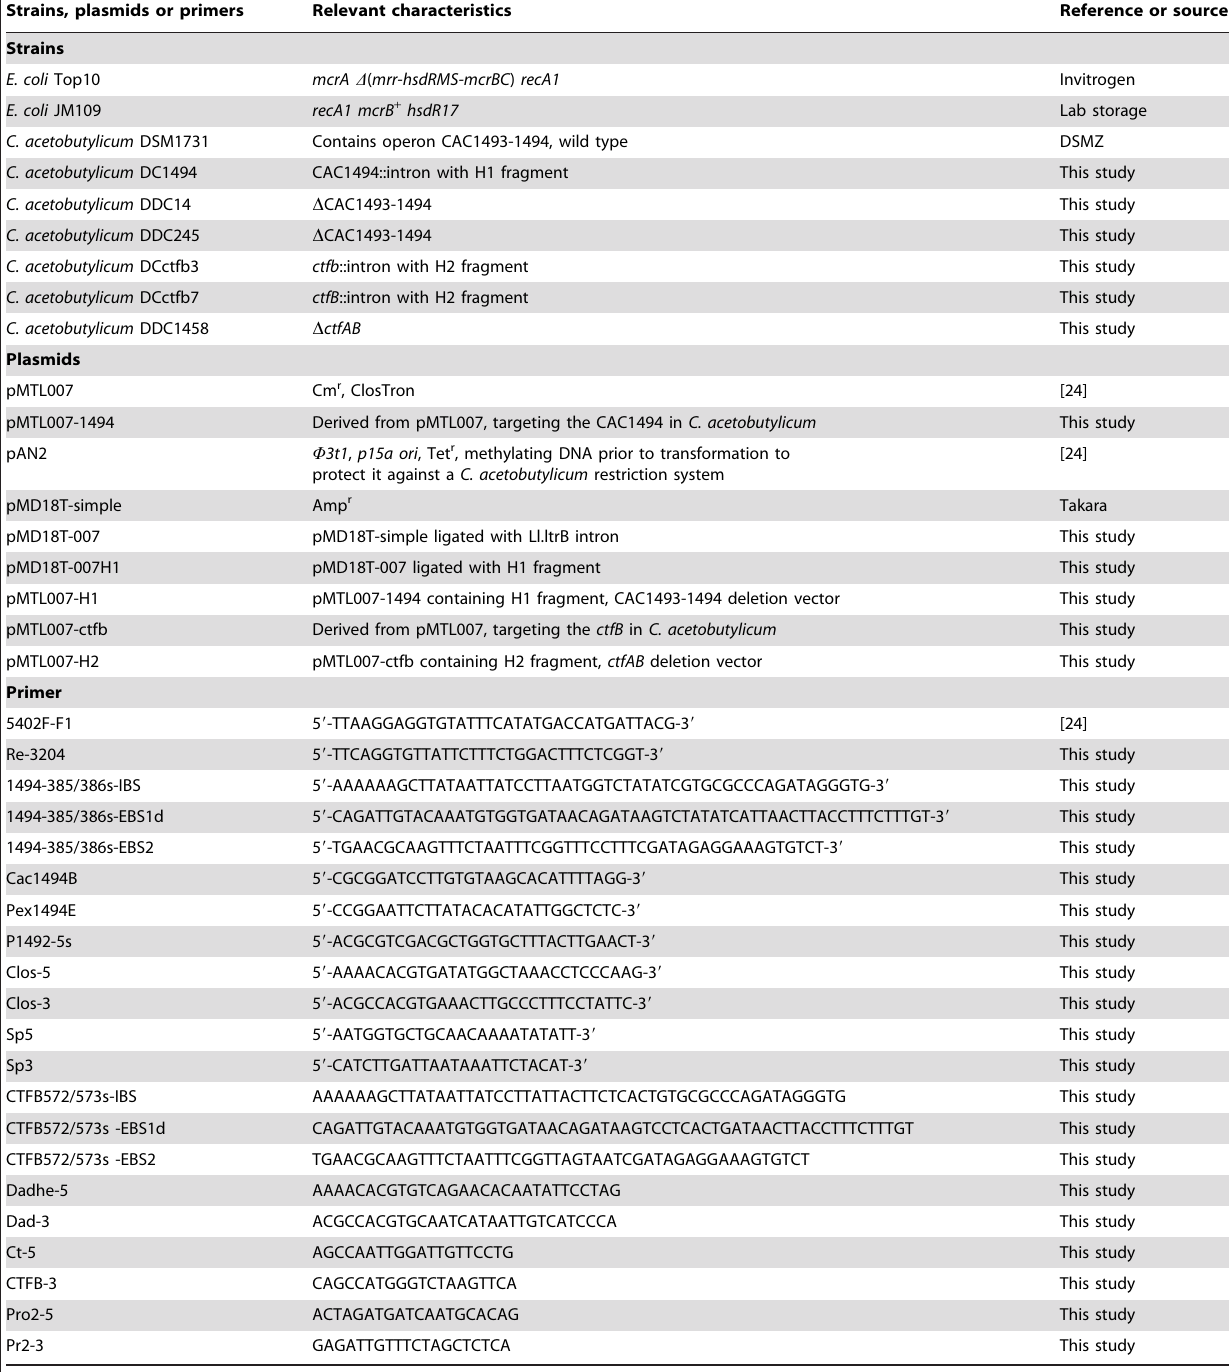
Table. 1. Bacterial strains, plasmids and